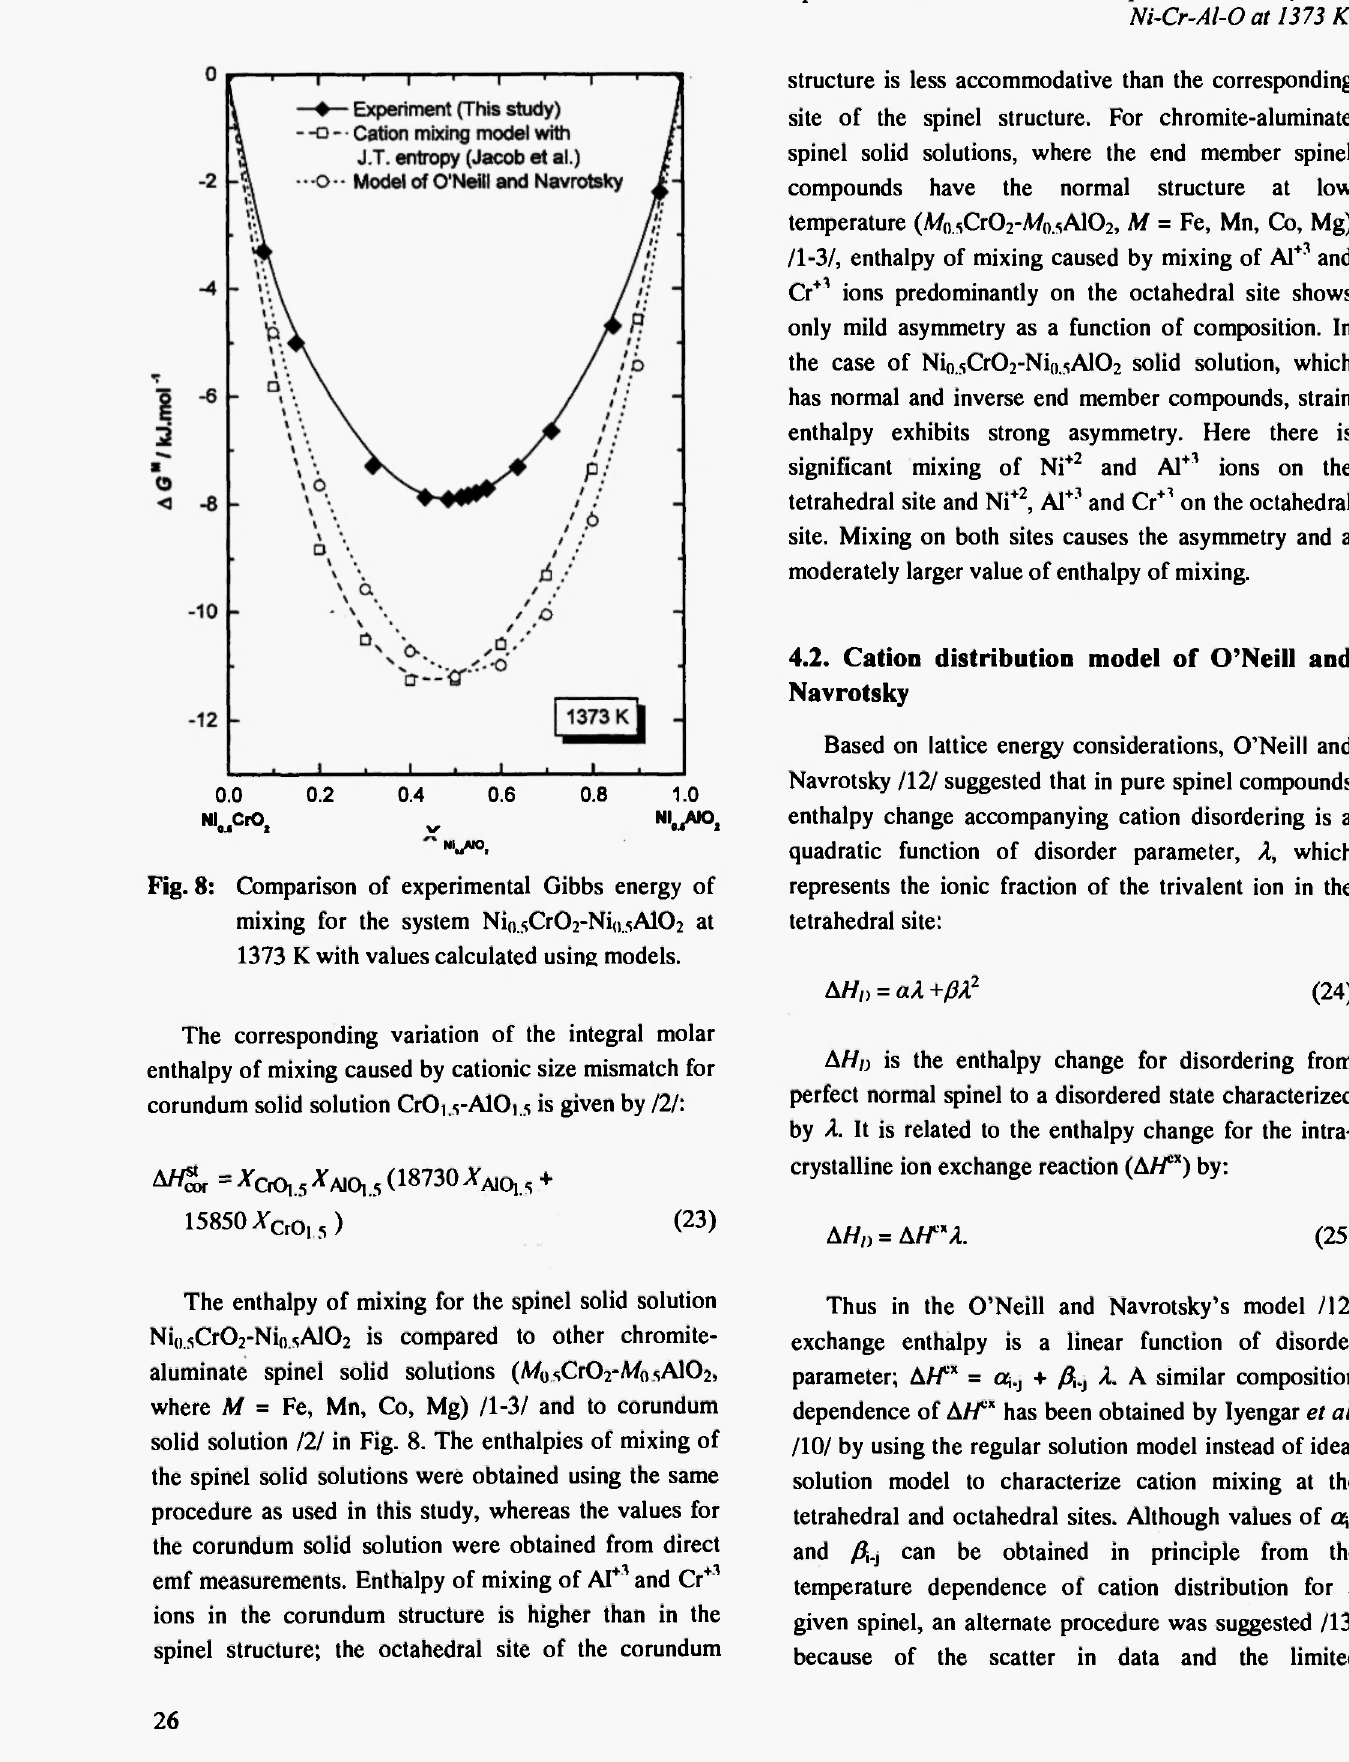
Fig. 8: Comparison of experimental Gibbs energy of mixing for the system Ni 1373 Κ with values calculated using